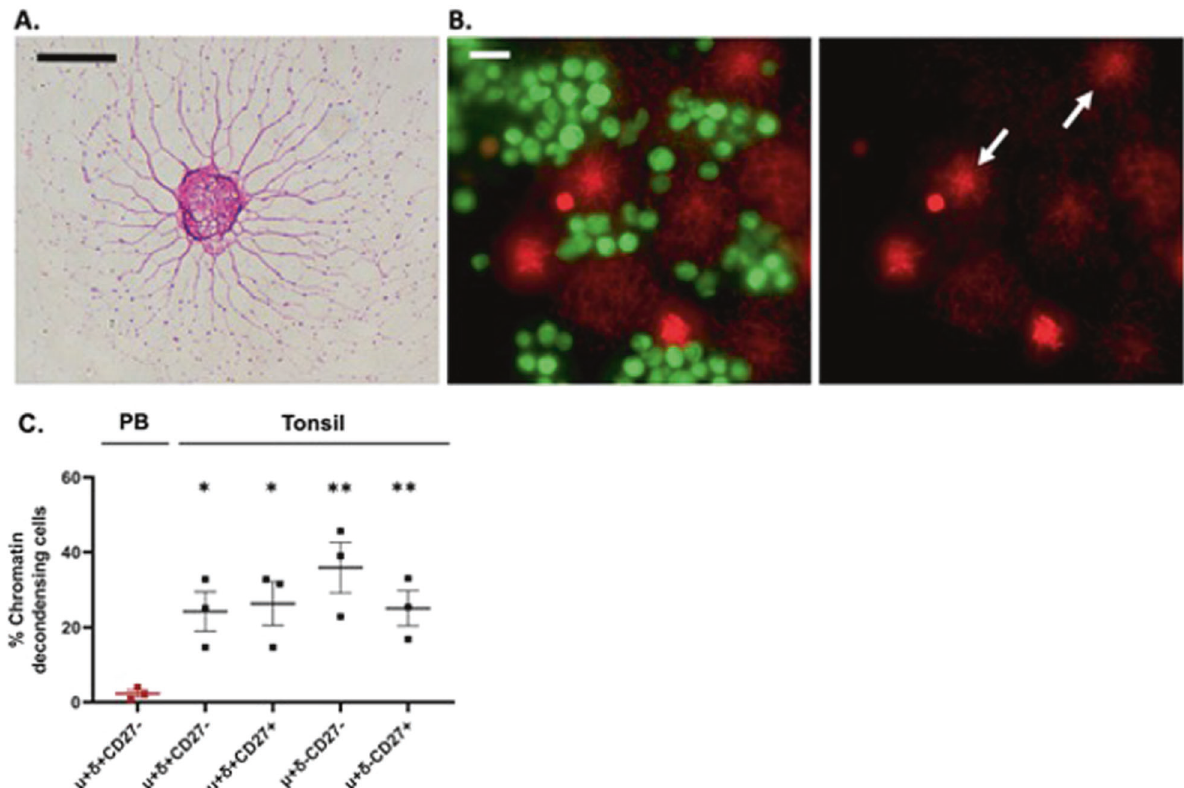
Fig. 1 Spontaneous death of tonsillar B cells. A Wright-Giemsa stain of human tonsil IgM + IgD + CD27- B cell after 1 h at 37 °C. Scale bar = 10 µm. B Tonsillar IgM + IgD + CD27- B cells stained with Calcein AM (green) and PI (red); PI-only shown in right panel. Scale bar = 10 µm. C Percent PB and tonsil B cells with chromatin decondensation after one 1 h culture. Tonsil B cell populations compared to PB. Each point represents a different sample; paired t -test, * P -value < 0.05, ** P -value <